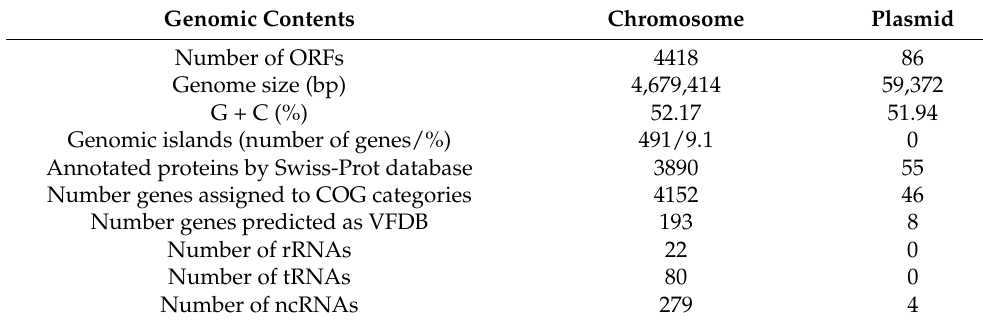
Table 1. Basic genome information of